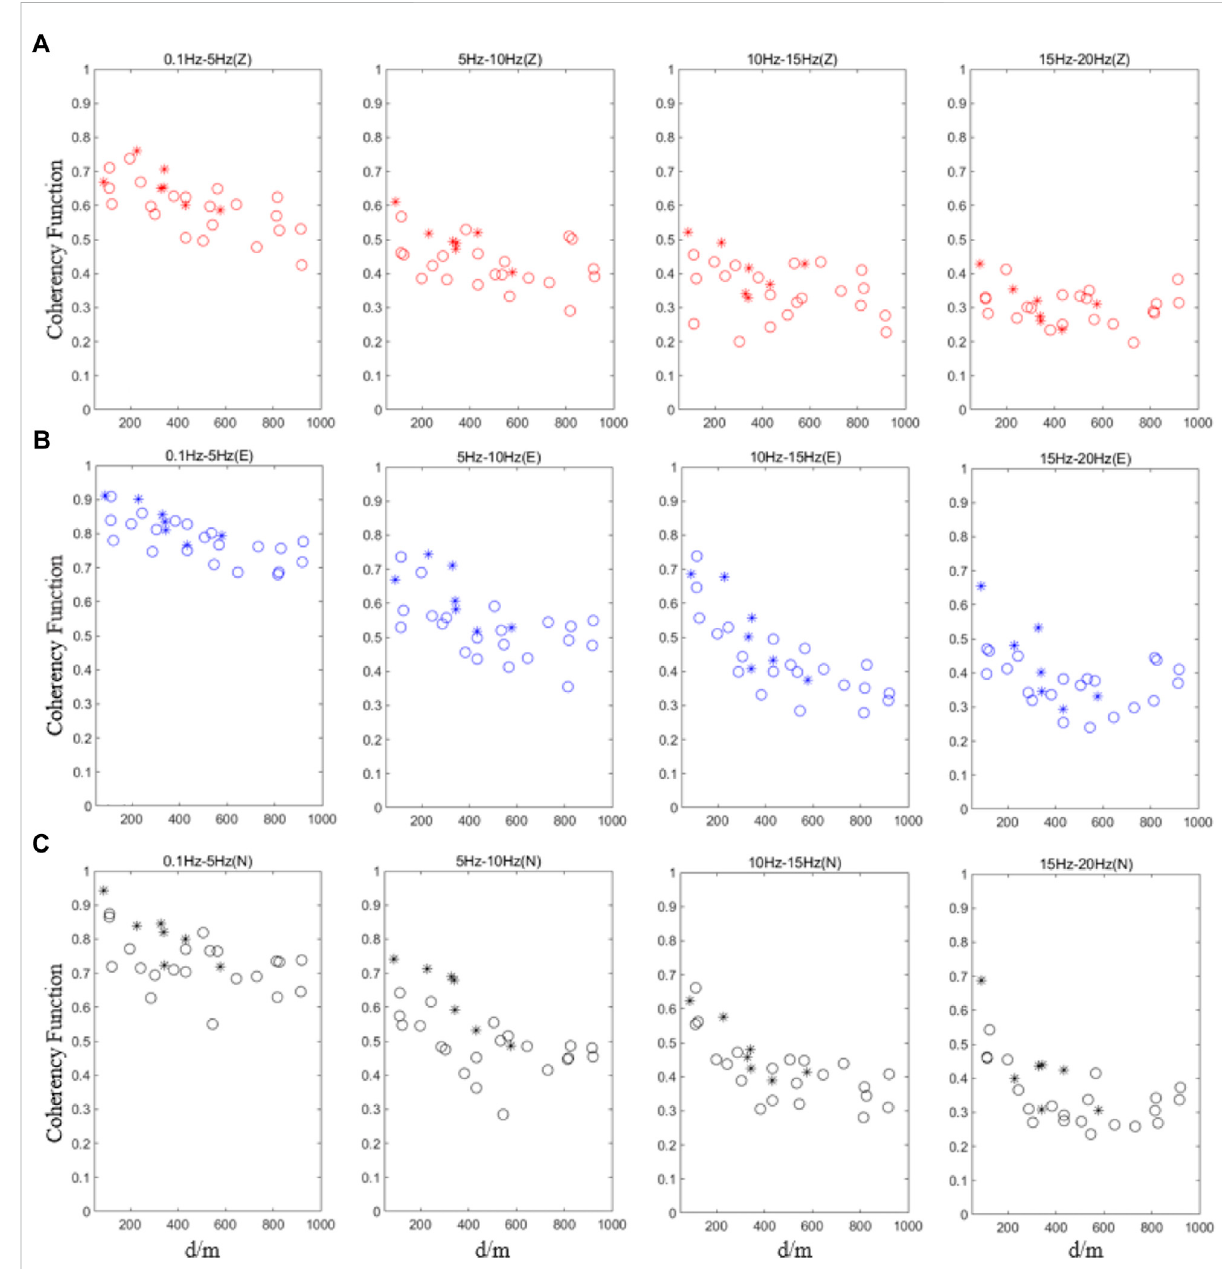
FIGURE 10 Variation in lagged coherency as functions of distance (the Yibin earthquake). The asterisk (*) represents the station pairs of the same site type, and the circle () represents the station pairs between other different site types. (A) UD component, (B) EW component, and (C) NS